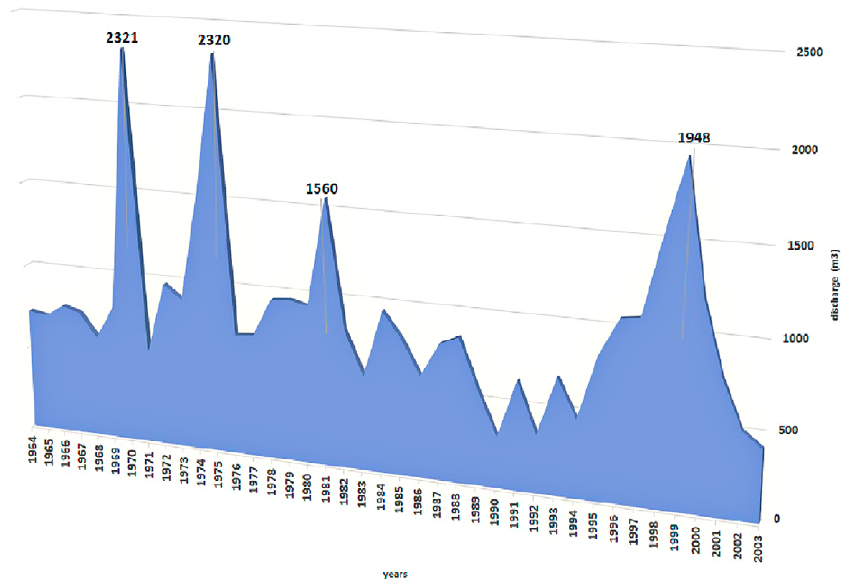
Figure 4. The maximum discharge at Arad hydrological station between 1964 and 2003 (after Zaharie,